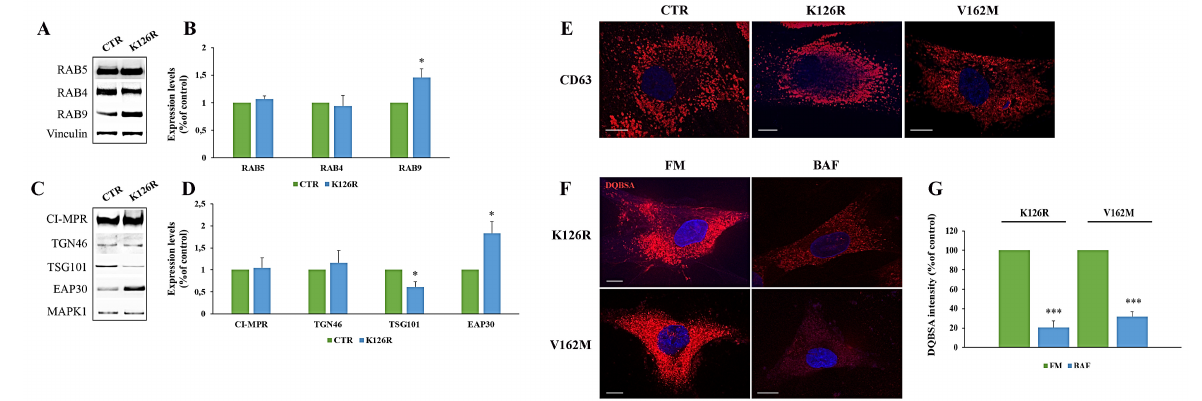
Figure 6. Analysis of endosomal markers in K126R mutated fibroblasts. ( A , C ) Lysates of control and CMT2B patient-derived skin fibroblasts carrying the RAB7 K126R mutations were analyzed by Western blotting using anti-RAB5, anti-Rab4, anti-Rab9, anti-CI-MPR, anti-TGN46, anti-TSG101 and anti-EAP30 antibodies. ( B , D ) Bands were quantified using ImageLab software (Bio-rad) and normalized against Vinculin and MAPK1. ( E ) Multivesicular bodies were immunostained using anti-CD63 antibody. ( F ) CMT2B fibroblasts were incubated in full medium (FM) and in the presence of 400 nM bafilomycin A 1 (BAF) for 24h. Then, cells were incubated in the presence of DQ-Red BSA and ( G ) fluorescence intensity analyzed by ImageJ software. Values are the mean ± SE of three different and independent experiments. * p < 0.05; *** p < 0.0001. Scale bar = 10 µ